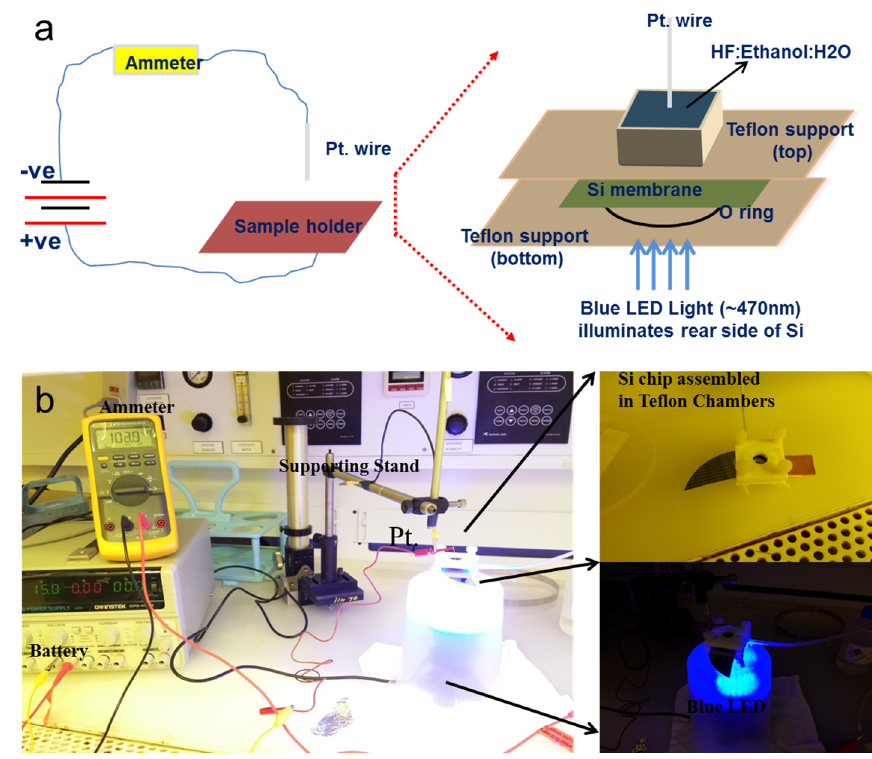
Figure 3. Photoassisted electrochemical fabrication of a solid ‐ state nanopore. ( a ) Schematic description; ( b ) Experimental demonstration.